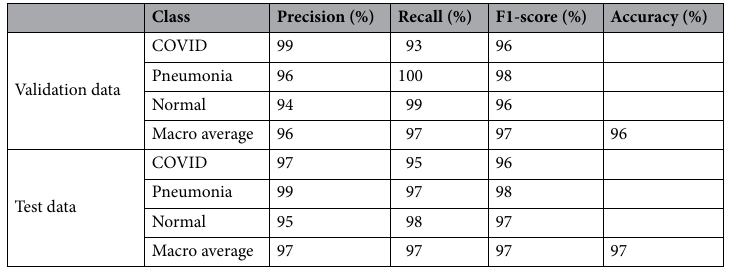
Table 3. The performance for the validation and test data of three-class classification.